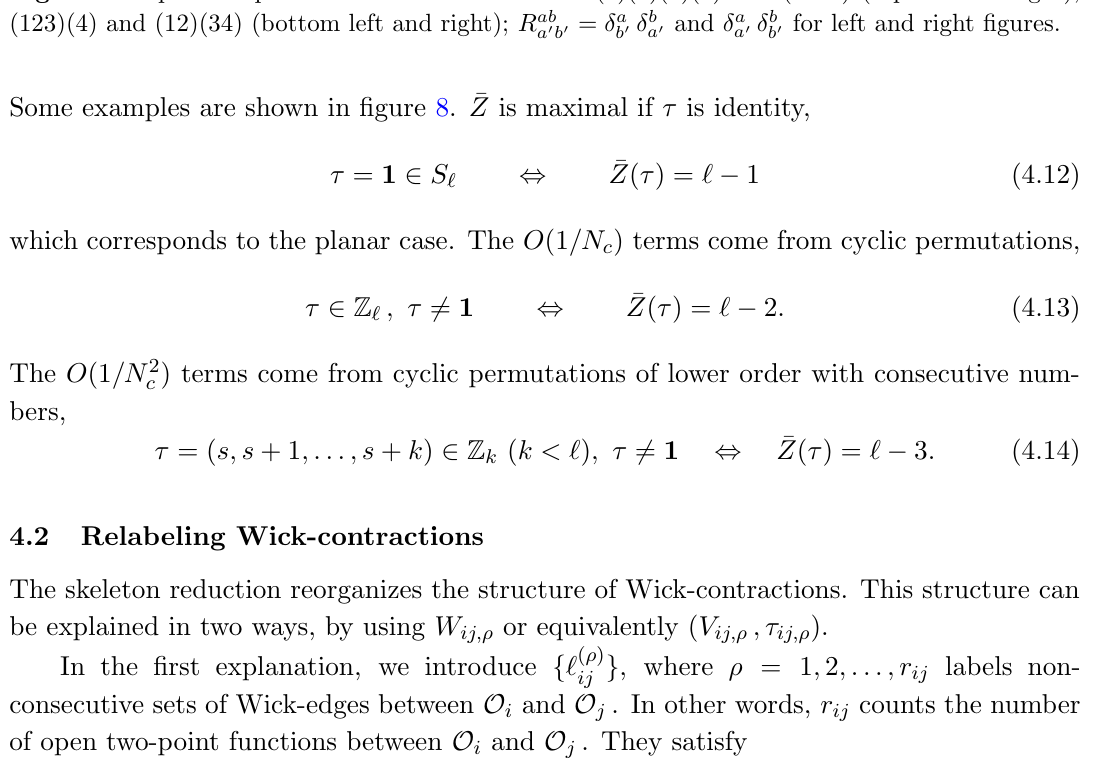
(cid:14) b (cid:14) b = (cid:14) a and (cid:14) a for left and right a 0 a 0 a 0 b 0 b 0 b 0